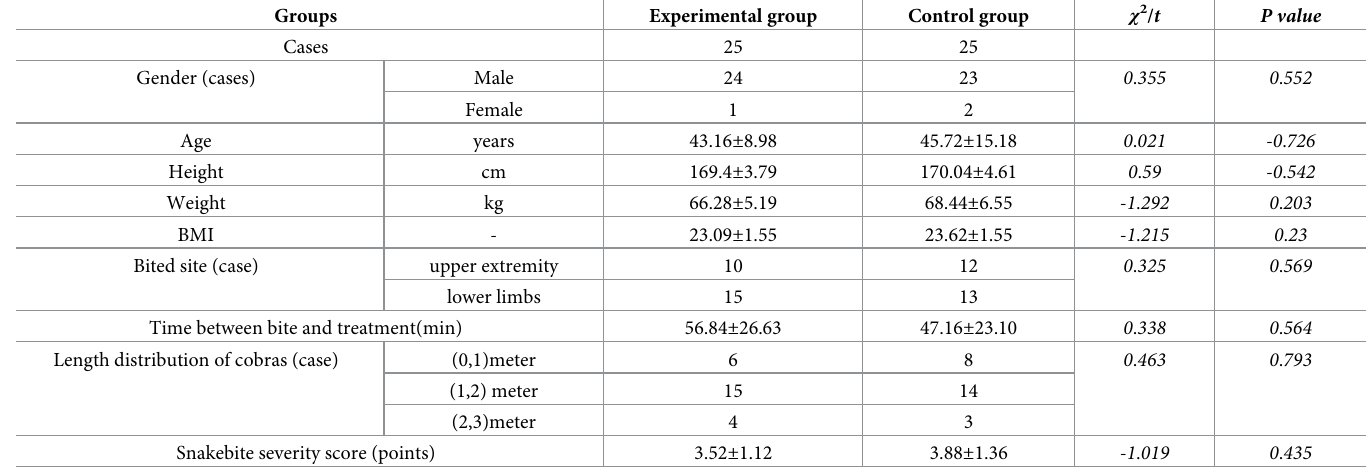
Table 2. Comparison of general data of cobra bite patients between the two groups. (Mean ± SD).